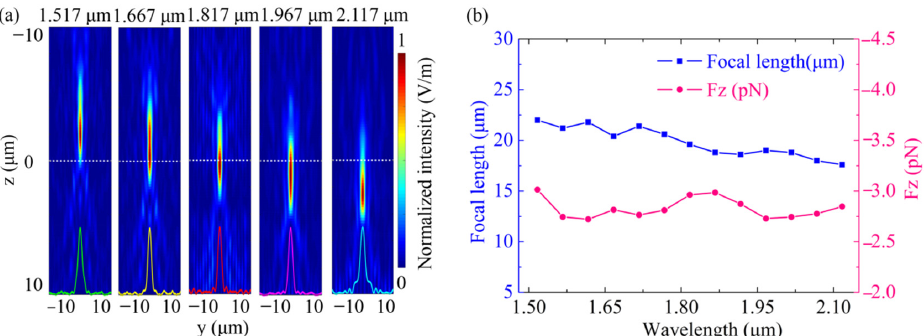
Figure 5. ( a ) Simulated intensity profiles of the focal point in the y - z plane of the metalens. The wavelengths of the incident field are 1.517, 1.667, 1.817, 1.967 and 2.117 μ m, respectively. The inset curves show the normalized intensity profile along the dashed white line. ( b ) The OPF (the pink line) and the focal length (the blue line) as a function of wavelength ranging from 1.517 to 2.117 μ m. The metalens has a width of 20 μ m, a focal length of 20 μ m, NA = 0.4. The position of the metalens is z = 20 μ m, and the position of the light source is z = 0 μ m.